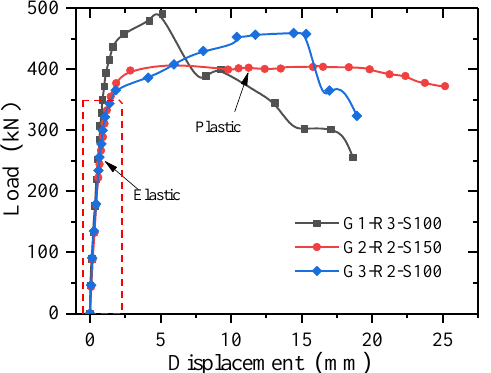
Figure 10. Load–slip curves for the slot–type perforated plate connections.